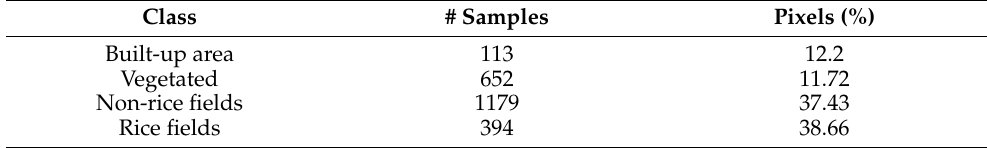
Table 4. Inventory of training polygons used for Random Forest